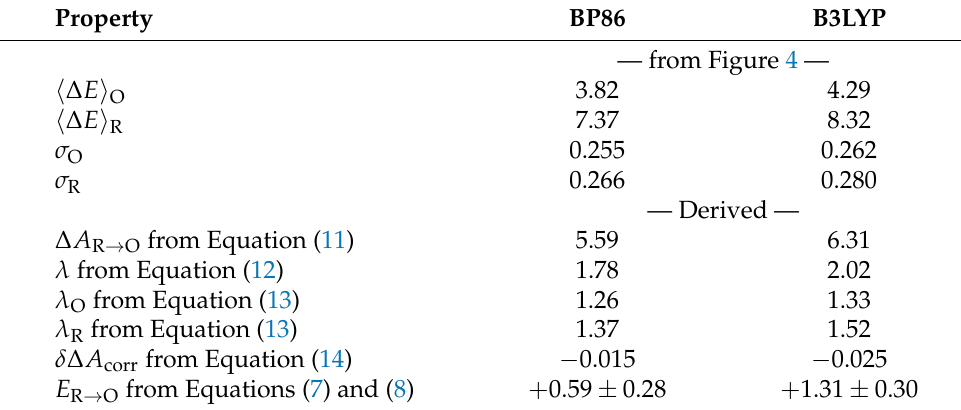
Table 1. Results of the reduction potential computation (all in eV, except E R → O in V) for MnV WOC using BP86 and B3LYP, based on 2000 snapshots from two MM MD trajectories.